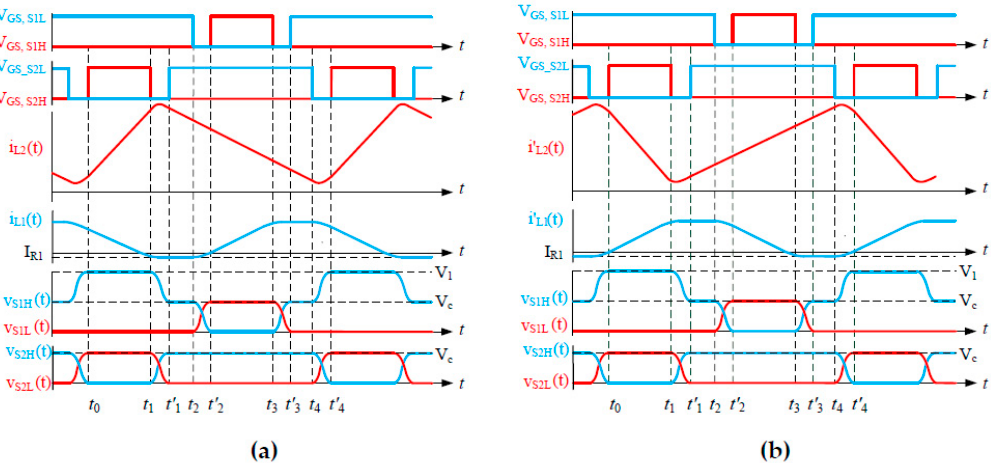
Figure 3. Key waveforms of the high-voltage-gain bidirectional DC–DC converter in TCM operation: ( a ) forward direction; ( b ) reverse direction.